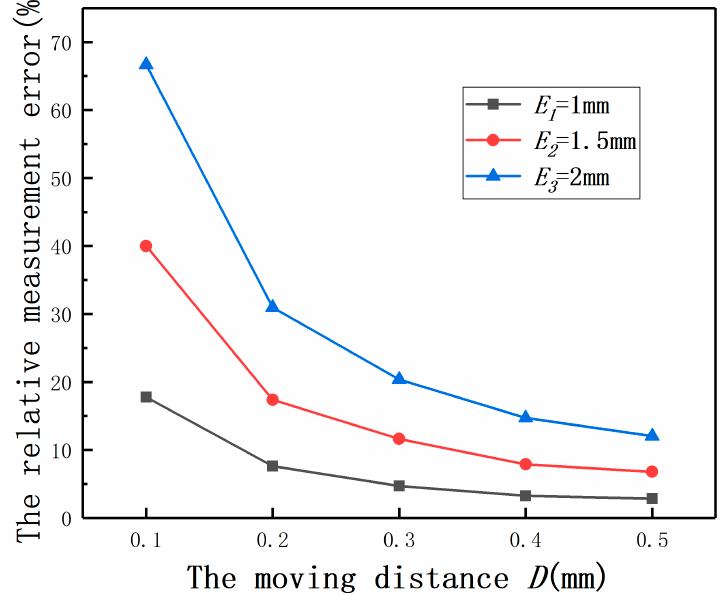
Figure 30. The relationship between the output and the moving distance under different eccentricities.